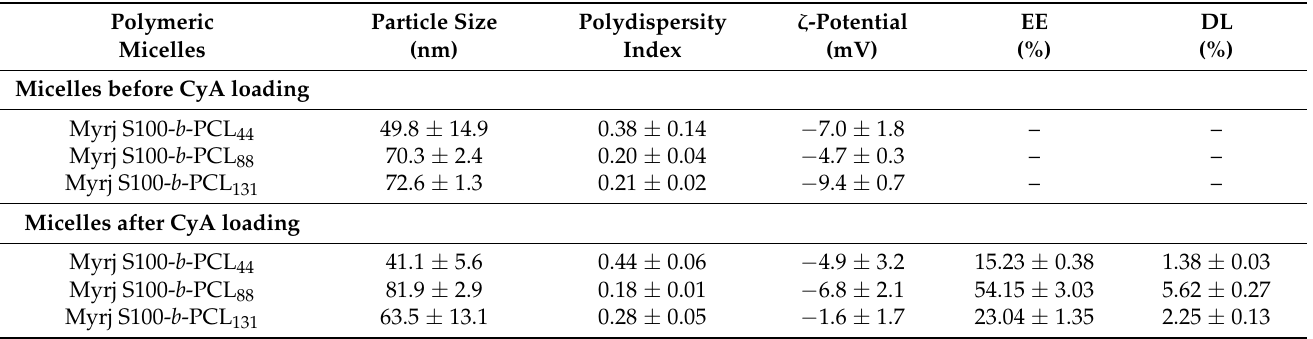
Table 2. Physical characterization of micelles before and after drug loading. Results are expressed as mean with ± SD, n = 3 .